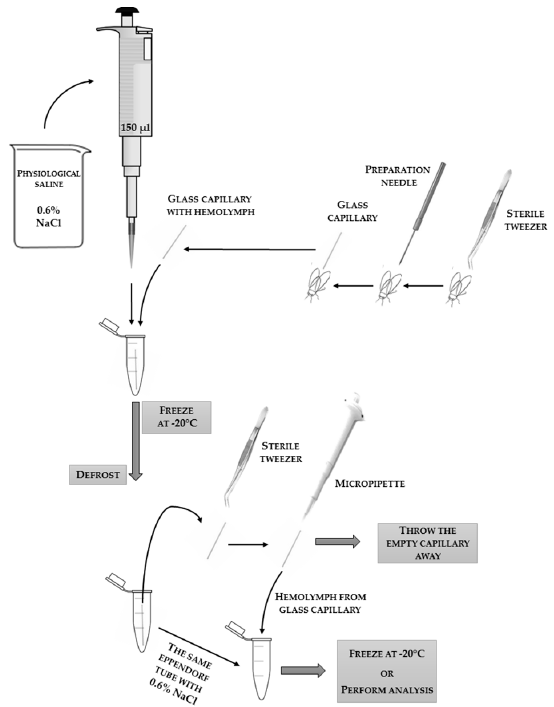
Figure 3. The scheme of the technique of collecting hemolymph into a glass capillary (e.g., 10 µL; the “end-to-end” type; without anticoagulant; Medlab Products) after puncturing the insect’s body (abdomen) with a sterile preparation needle. The applied tools and reagents, along with the used volumes, are presented in the scheme. The bottom part of the scheme shows the steps of blowing out the hemolymph from the glass capillary in order to suspend it in physiological saline to conduct analyses.